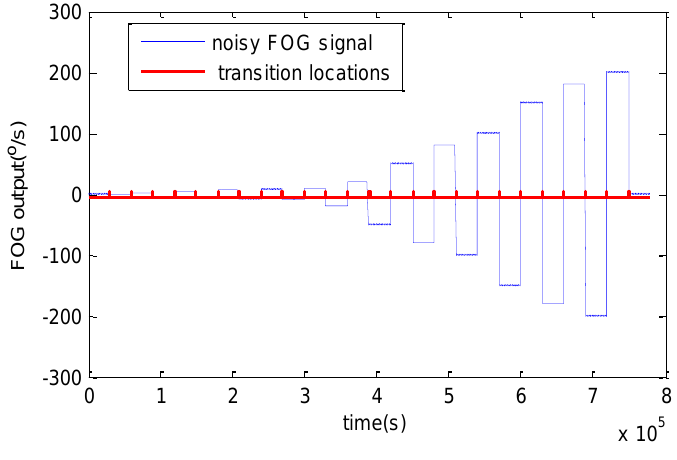
Figure 9. Detected discontinuities using AMA.